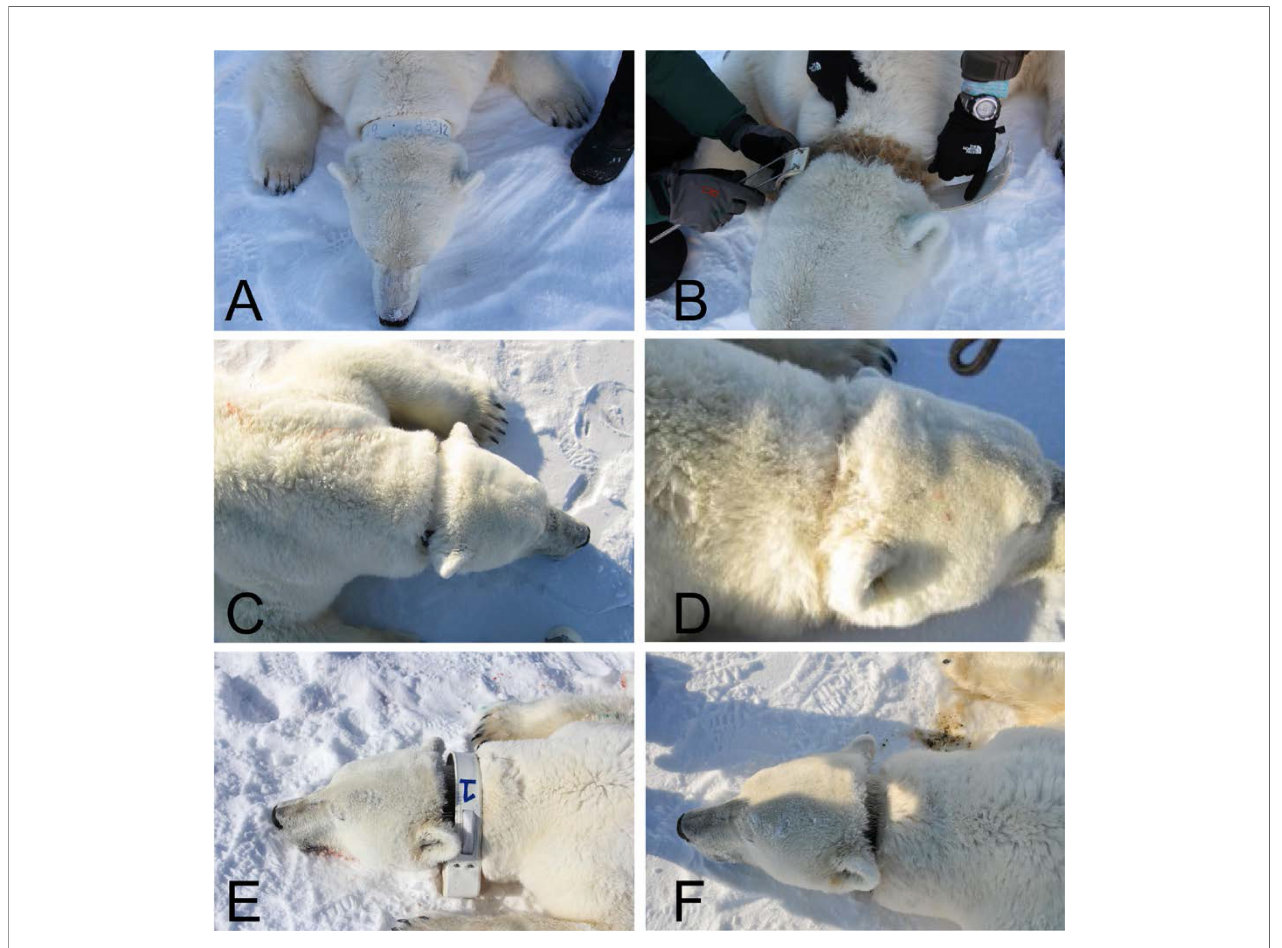
FIGURE 4 | (A-F). Three adult female polar bears shown when satellite telemetry collar was deployed (left) and when it was removed (right). (A, B) show bear D24042 from East Greenland after one year. (C, D) show bear X35260 from Kane Basin after two years, and (E, F) show bear D7388 from Baf fi n Bay after four years. Satellite telemetry collars can be deployed for different durations and controlled by release mechanisms or removal upon recapture. Discoloration is matted hair under the